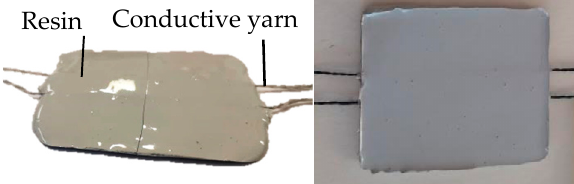
Figure 2. Example of the conductive yarn resin in the mould (side and front view).